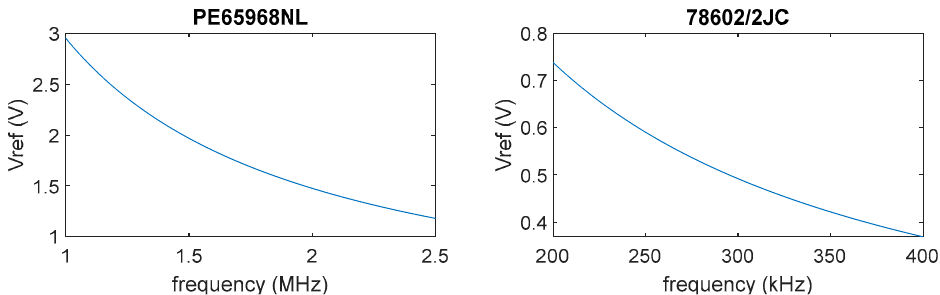
Figure 7. Values of 𝑉𝑟𝑒𝑓 to be employed in input to the prefluxing circuit for the PE65968NL ( left ) and the 78602/2JC ( right ) transformers in the frequency range 1–2.5 MHz and 200–400 kHz.